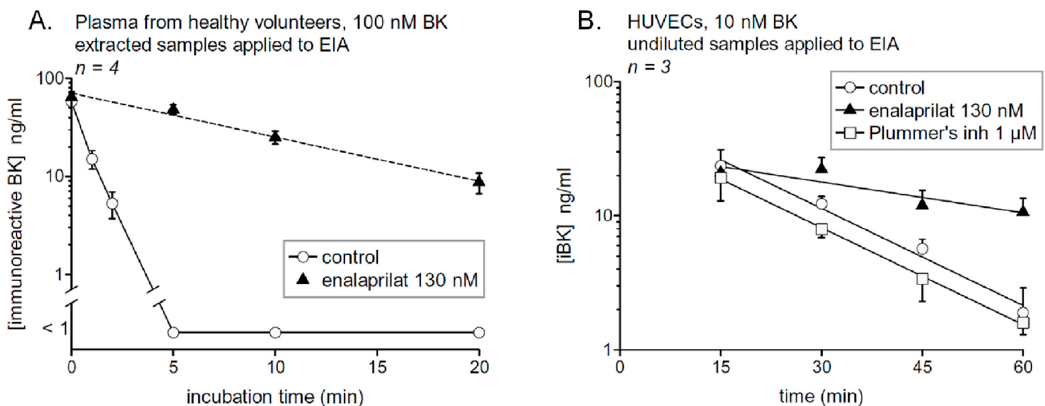
Figure 3. ( A ) Degradation of synthetic BK (100 nM) added to human plasma from healthy subjects in the presence or absence of the ACE inhibitor enalaprilat. Samples were incubated at 37 °C under agitation for the indicated time periods before extraction and EIA determination of BK. The number of replicated from different healthy donors is indicated by “ n ”. In the presence of the ACE inhibitor, the data are compatible with a first order decay with a half-life of 7.1 min, whereas BK was completely cleared in 5 min the absence of enalaprilat ( t 1/2 34 s). Reproduced from [18]. ( B ) Catabolism of BK, measured as [iBK], by intact HUVECs as a function of time. Values are means ± s.e.m. of 3 determinations. A first order decay model has been applied ( t 1/2 values reported in main text). BK added to similar wells without cells (nude plastic) was stable when incubated in an identical manner (data not shown).